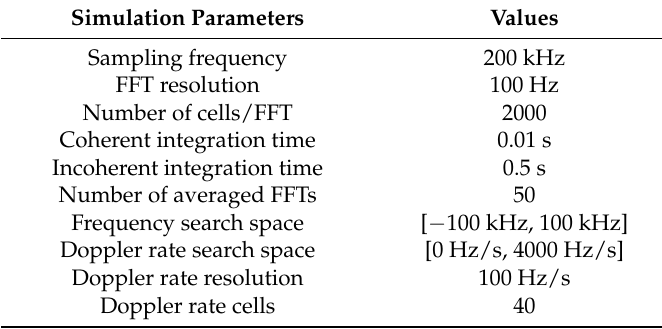
Table 1. Simulation parameters for 2D search approach. FFT: fast Fourier transform.